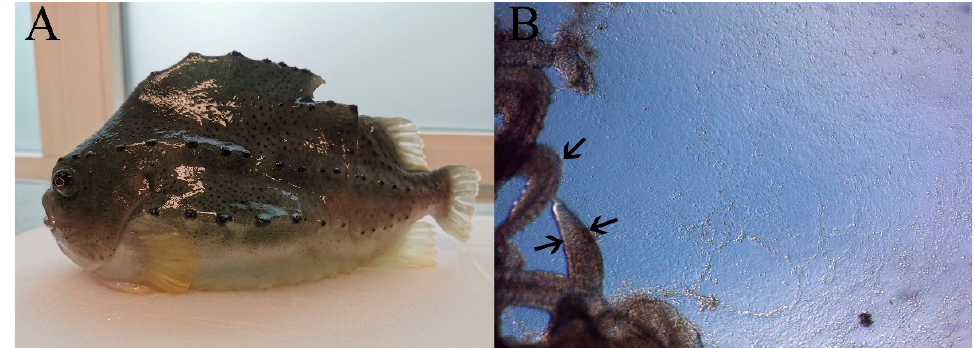
Figure 1. Lumpfish ( A ) and explants ( B ) from lumpfish gills, with gill filaments (left, indicated by arrows), an extensive growth of cells from the explant (middle and right part) and a confluent layer of cells (4 days after seeding). The thickness of the gill filament indicated by the arrows is about 200 µm. Microscope: Leica DMIL.